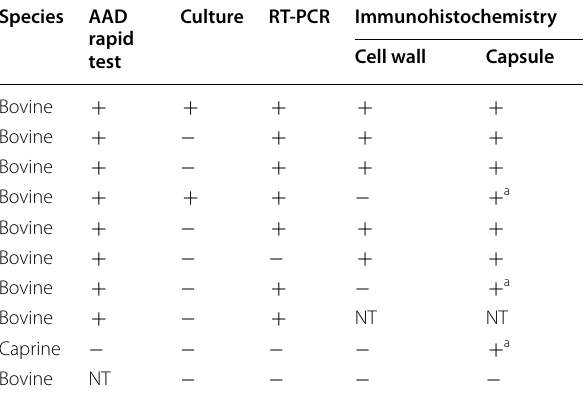
Table 3 Summary of anthrax diagnostic testing result, by carcass sampled, in Kiruhura District, Uganda, May